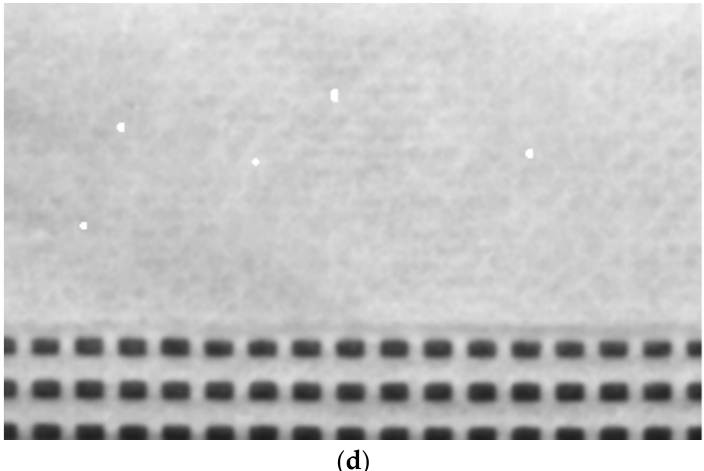
Figure 3. ( a ) Normal mask image; ( b ) nonlinear defect mask image; ( c ) dotted defect mask image; and ( d ) dotted defect mask image.